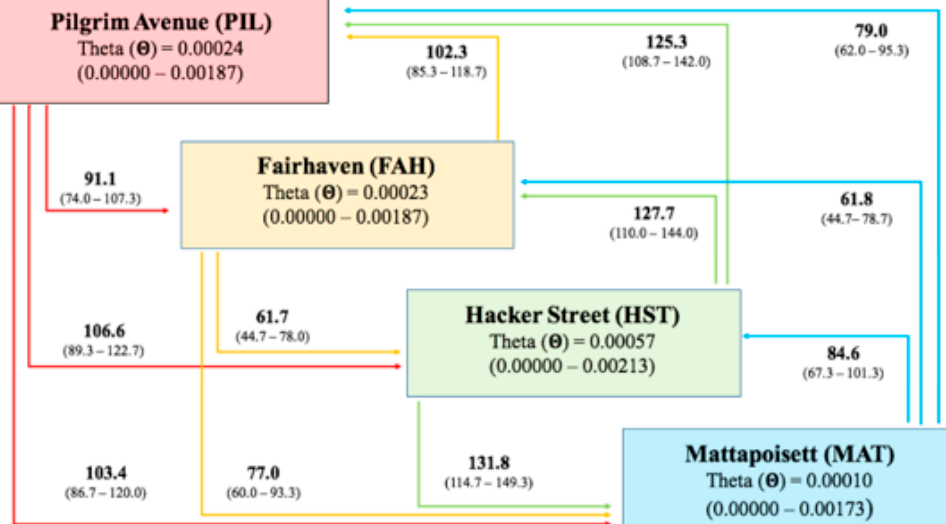
Figure 2. Pattern of historical gene flow from the Migrate-n simulation. The squares represent the four sampling locations and theta ( Θ ) values with 95% confidence intervals. Colored arrows refer to the sampling location of the same color and explain the directionality and rate of gene flow (M values are reported at the corner of each arrow with a 95% confidence interval).